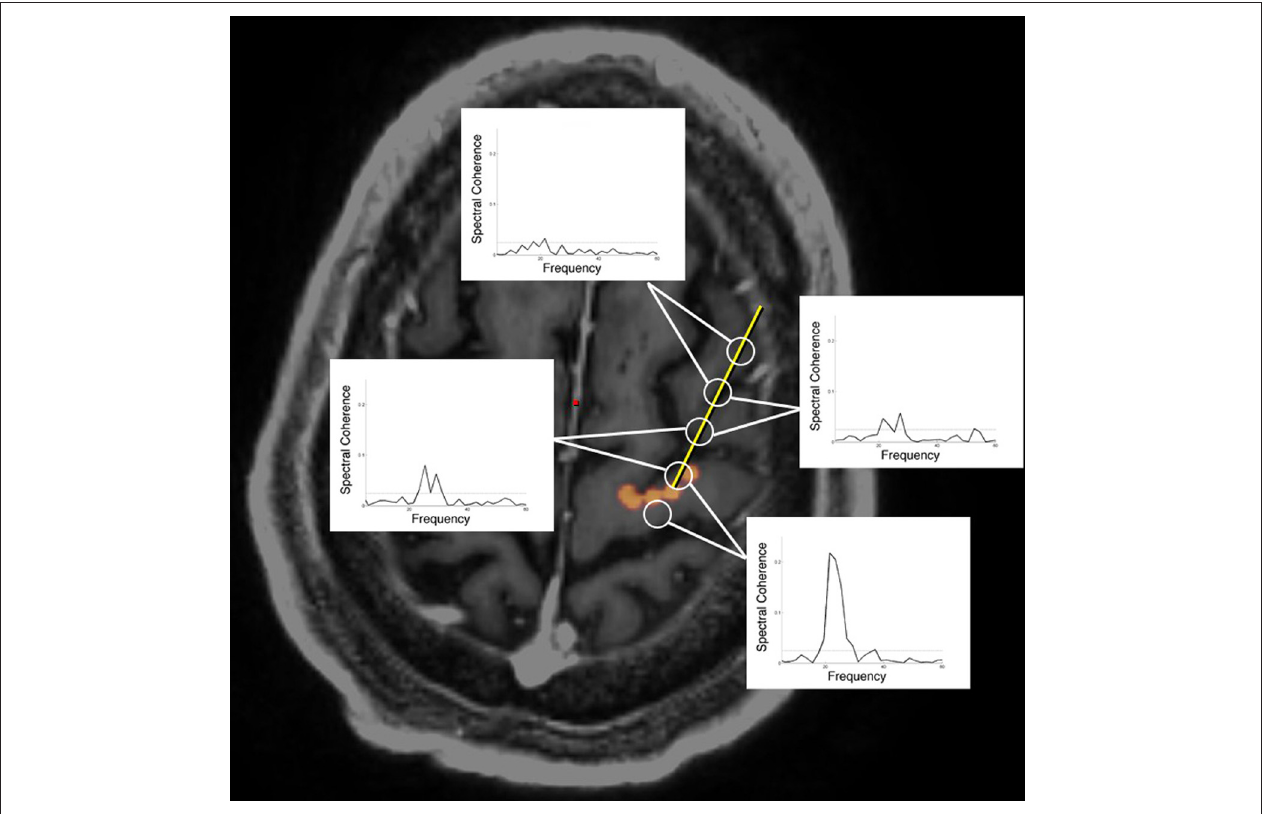
FIGURE 1 | Oscillatory coherence demonstrated between cortex and subthalamic nucleus during DBS surgery. A six contact cortical strip recording electrode (open circles) was introduced through a 14mm burrhole to arrive at the origin of the hyperdirect pathway (denoted in orange) as